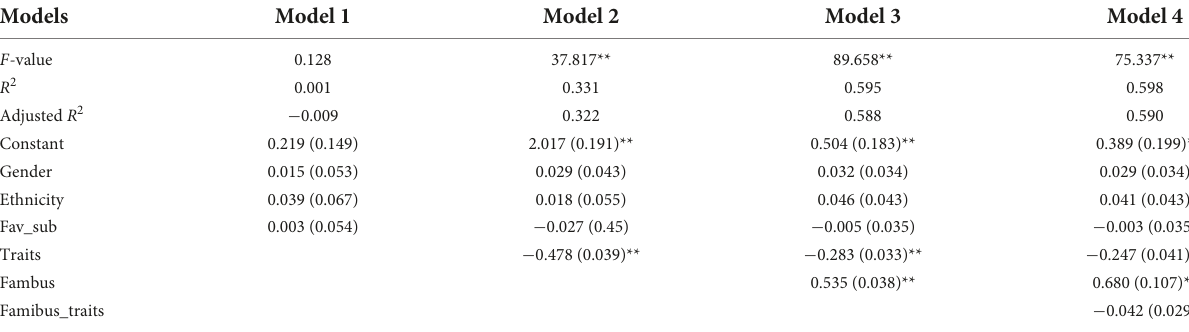
TABLE 4 Hierarchical regression results: The role of entrepreneurial traits and family business on self-employment intention.